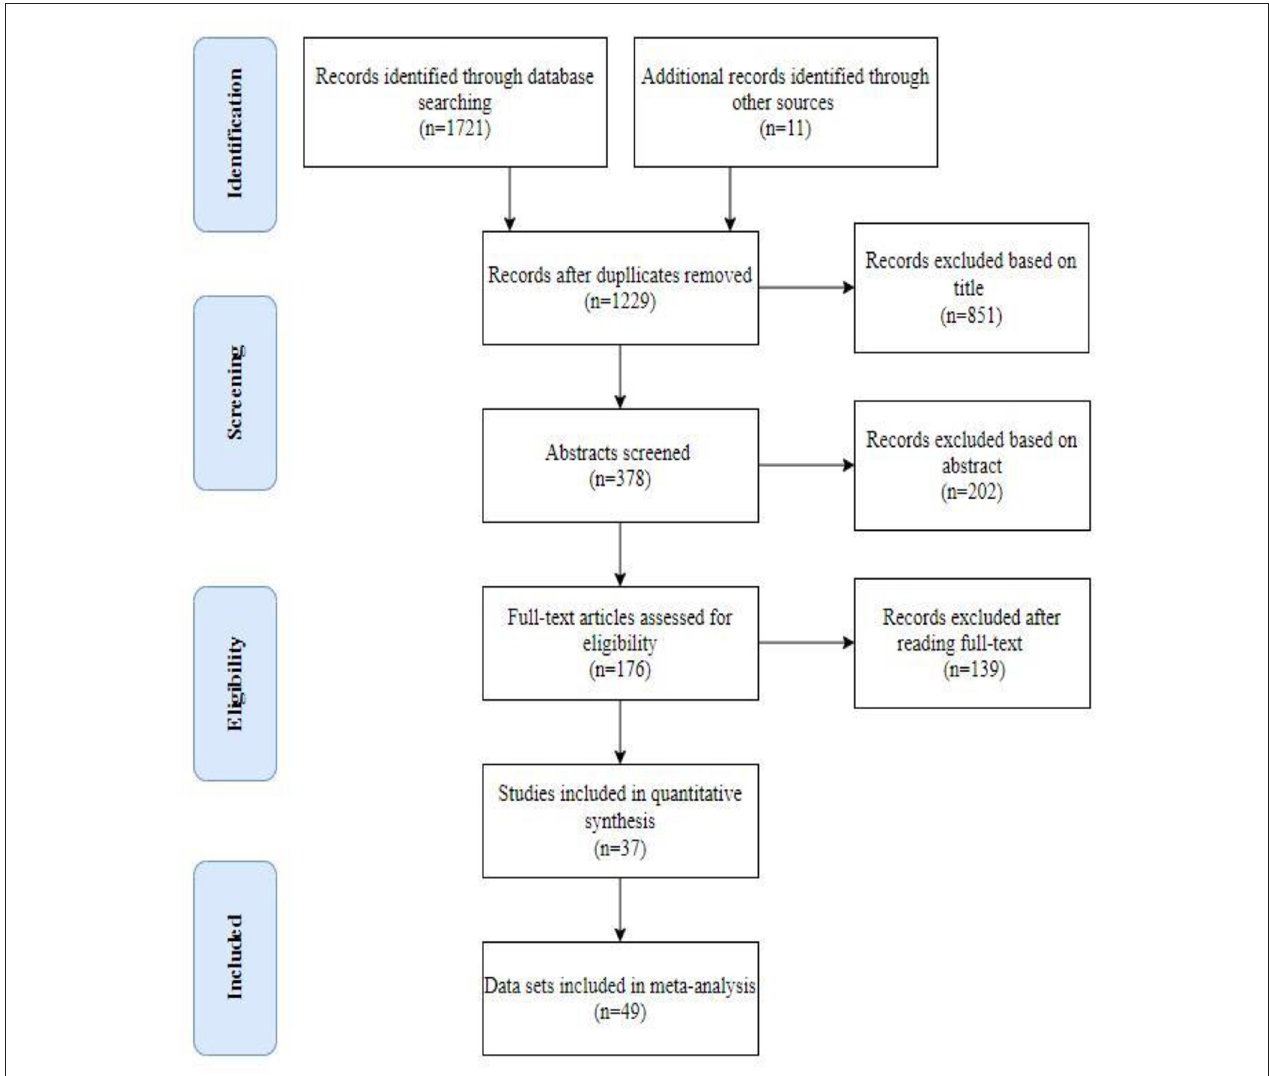
FIGURE 1 | PRISMA flow diagram for articles identified, screened eligible, and included in this paper.